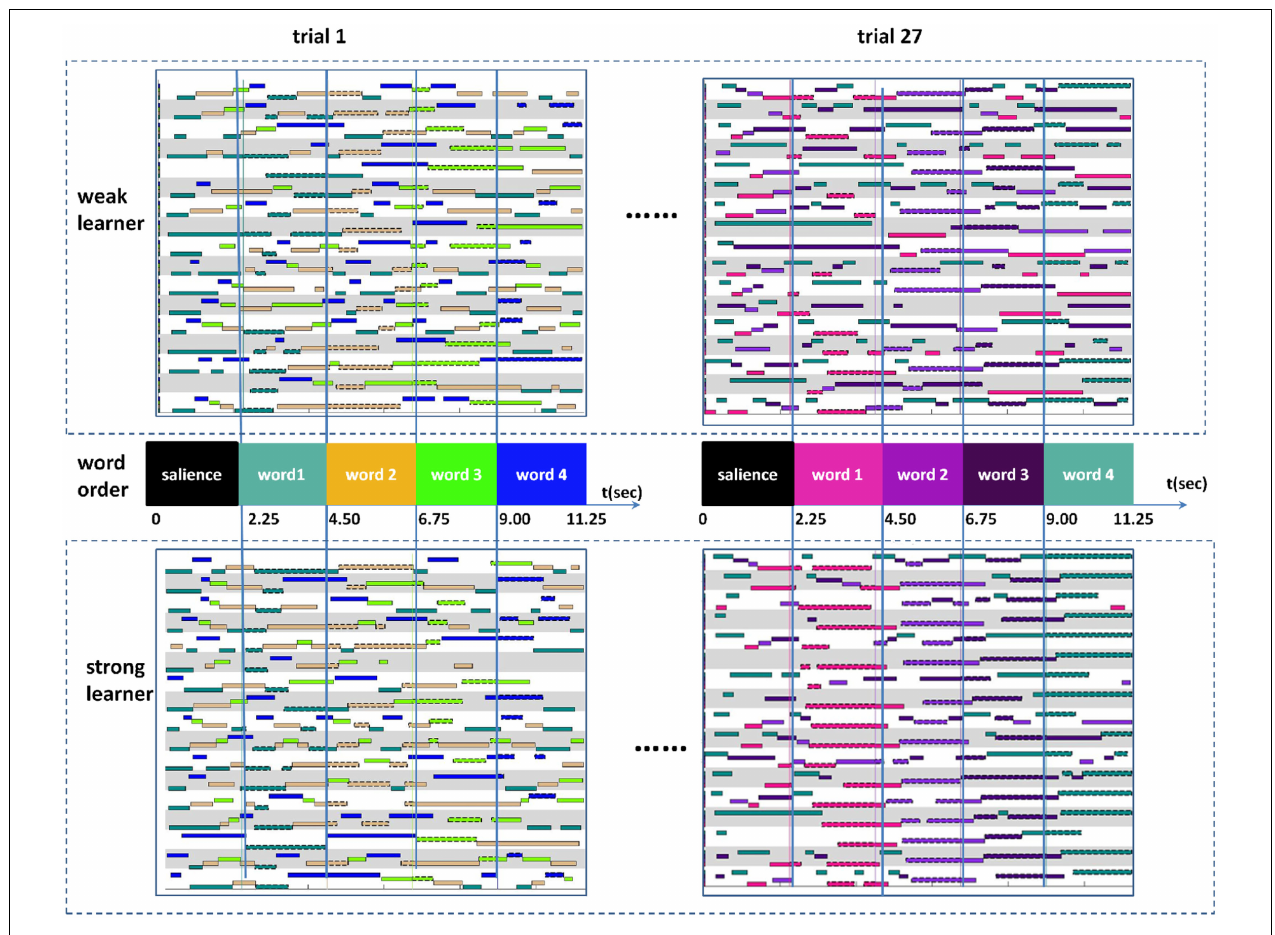
trial, there were four distinct colors in each panel. Each row in a panel shows a temporal sequence of eye fixations from a participant when hearing four words sequentially. Both learner groups started with rather random looks. However, at the last learning trial, strong learners show more consistent gaze patterns toward correct objects after hearing corresponding